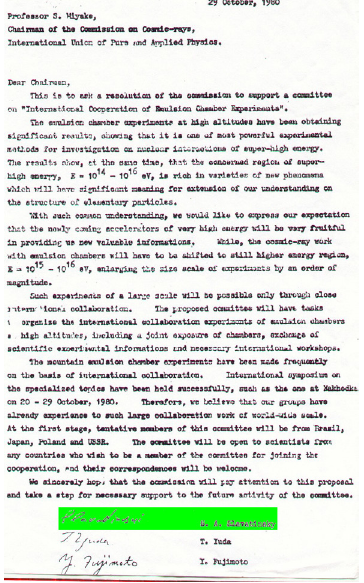
Figure 10. Request to C4 / IUPAP2.